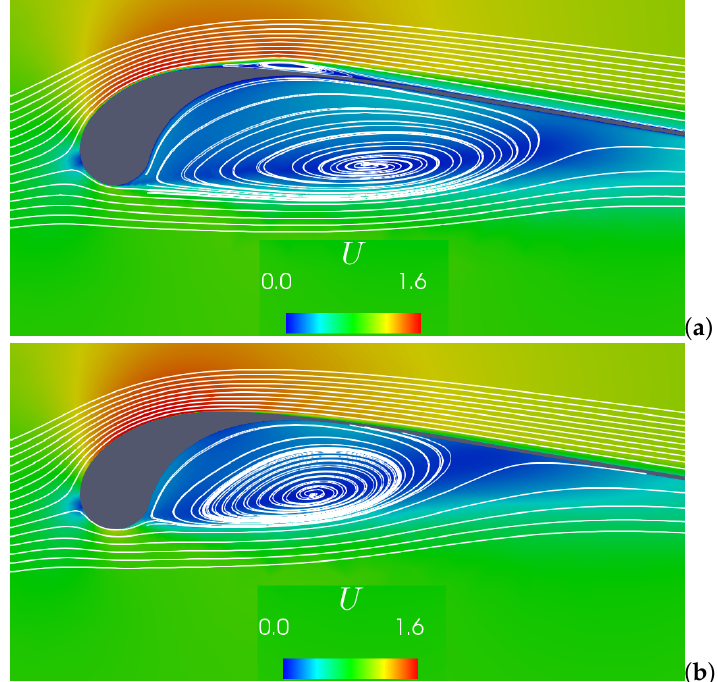
Figure 8. Streamlines and magnitude of the velocity field in the wing symmetry plane ( Z = 0) for α = 6 ◦ , taken from [23]: ( a ) Re = 10 5 and ( b ) Re = 3 × 10 6 .